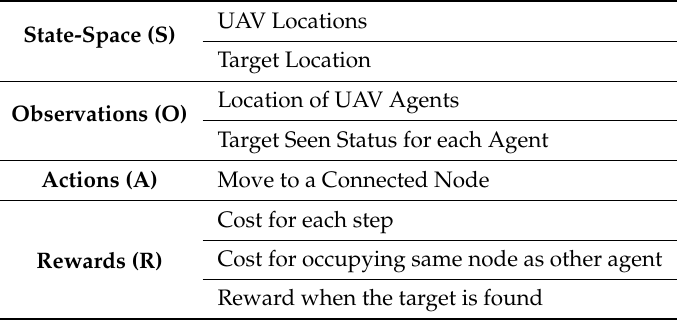
Table 1. Global Planner POMDP